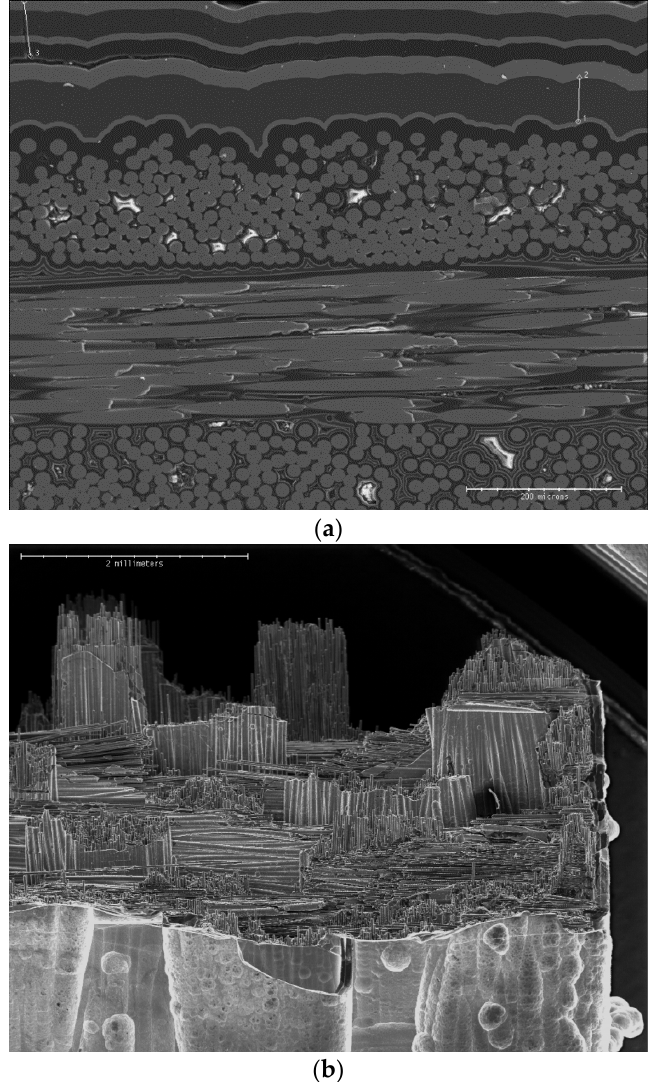
Figure 1. ( a ) SEM micrograph of the cross-section of SiC f /[Si-B-C] composites; ( b ) Typical fracture surface of SiC f /[Si-B-C] composite.